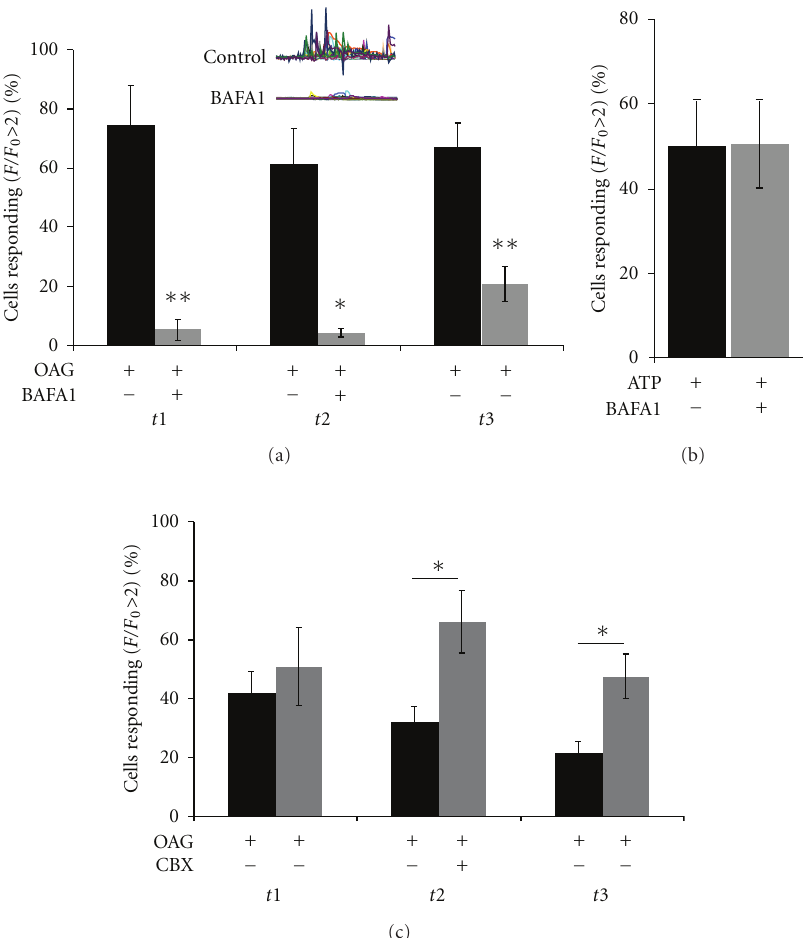
Figure 5: OAG-induced ATP release from astrocytes appears to be vesicular. (a) Incubation of cultured astrocytes with 100 nM Bafilomycin A1, an inhibitor of the vesicular H + ATPases that set up the proton gradients necessary for vesicle filling, greatly reduced OAG-induced astrocytic ATP release (bafilomycin n = 8, control n = 5; t 1 P = 0 . 01, t 2 P = 0 . 02, t 3 n = 0 . 004). This e ff ect was partially washed out after 15 minutes ( t 2 baf versus t 3 wash P = 0 . 024). (b) Bafilomycin treatment did not a ff ect the function of astrocytic ATP receptors, as the calcium response to 1 µ M ATP was una ff ected by bafilomycin treatment (bafilomycin n = 5, control n = 5, P = 0 . 9). (c) The gap junction and hemichannel blocker carbenoxolone (CBX), at 50 µ M, resulted in an increase in astrocytic ATP release (control n = 14, CBX n = 5; t 2 P = 0 . 03, t 3 P = 0 .